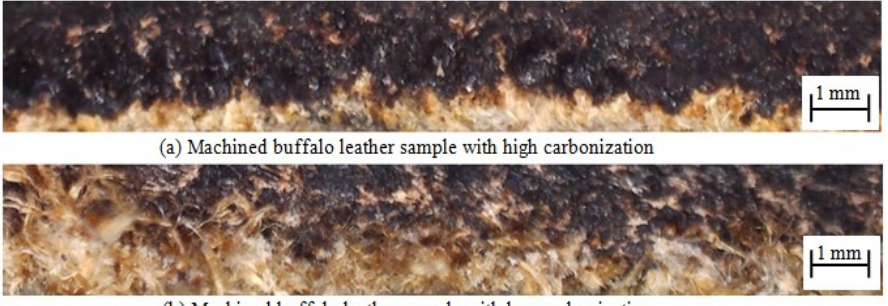
Figure 6. Carbonization layer on laser-machined leather under trial 5.